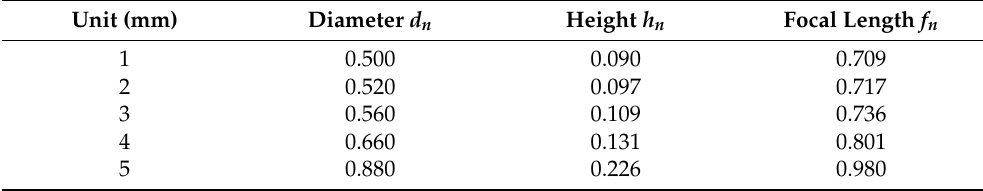
Table 1. Diameters, heights, and focal lengths of the